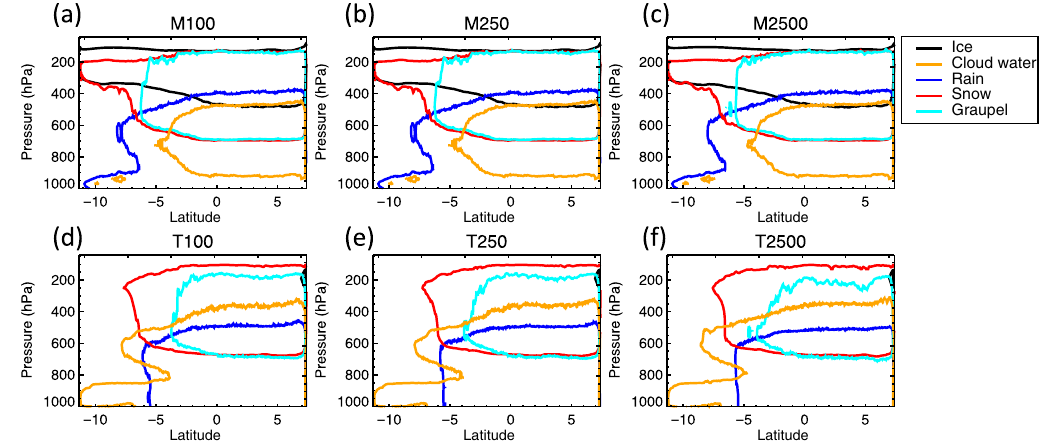
Figure 4. Congo case: zonal mean vertical sections of hydrometeor classes (colour contours) from 1 to 10 August 2007. Hydrometeor mass mixing ratios are contoured at 10 − 6 kgkg − 1 .